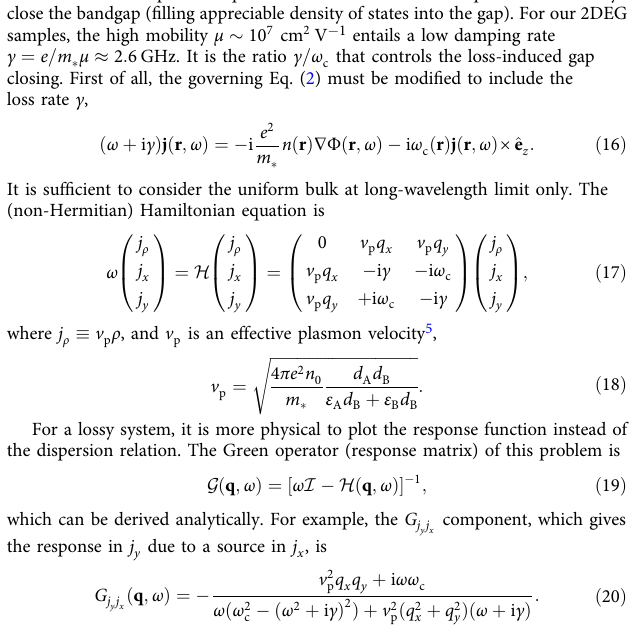
Fig. 8 Impact of loss on magnetoplasmonic dispersion. Color plot of response function G j